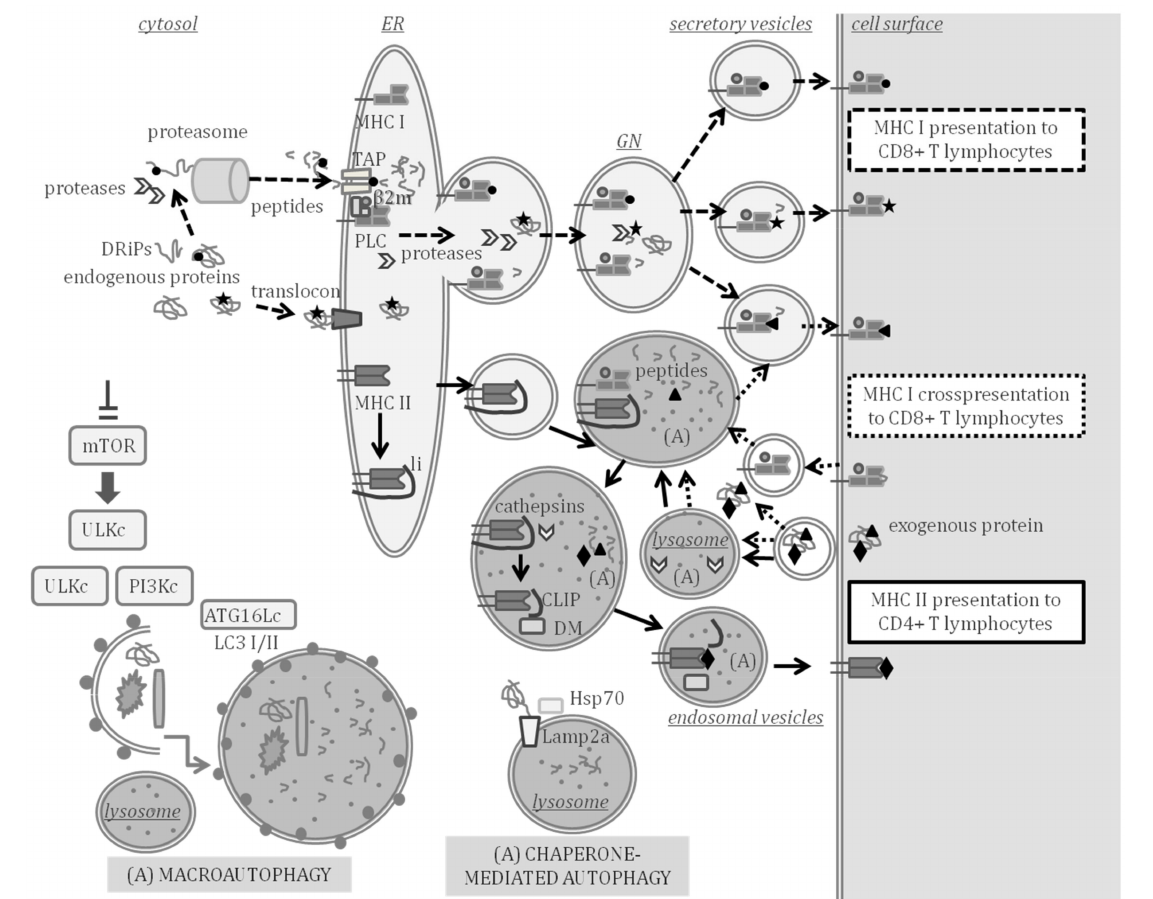
Figure 1. Major histocompatibility complex (MHC) class I and II antigen processing and presentation (APP) and autophagy. MHC class I presents endogenous peptides produced in the cytosol (peptide represented by a circle) or in secretory compartments (star) to CD8 + T lymphocytes through the pathways indicated with the dashed arrows. Endogenously synthesized proteins and defective ribosomal products (DRiPs) are processed to peptides in the cytosol by the proteasome and cytosolic proteases. Peptides are then transported by transporter associated to antigen processing (TAP) to the ER where the peptide loading complex (PLC) is formed by a peptide, TAP, MHC class I, β 2- microglobulin ( β 2m) and other assistant proteins. Endogenous proteins can enter the lumen of the ER through the translocon and be processed by proteases of the ER or the Golgi network (GN), thus, producing peptides that can also be loaded on MHC class I beyond the ER. Loaded MHC class I molecules are transported to the cell surface in secretory vesicles. MHC class I can also cross present peptides and prime CD8+ T lymphocytes through the pathway indicated with the dotted arrows. Cross-presented peptides (triangle) are produced by processing exogenous antigens in the cytosol or in secretory or endocytic compartments in which autophagy (A) may take place. MHC class II presents peptides (diamond) processed from exogenous proteins to CD4 + T lymphocytes through the pathway indicated with the continuous lined arrows. In the ER, MHC class II molecules are assembled and bind to the invariant chain li. The MHC class II is exported to endosomal compartments, in which autophagy can take place and where class II-associated invariant chain peptide (CLIP) remains bound to MHC class II after cleavage of li by lysosomal cathepsins. HLA-DM assists in the exchange of CLIP by a peptide that is exported to the cell surface through exocytic vesicles. Chaperone-mediated autophagy allows the targeting of cytosolic proteins to be degraded in lysosomes and is assisted by Lamp2a, Hsp70 and other chaperones. Macroautophagy is the engulfment of diverse cytosolic material to be degraded, induced by inhibition of the mammalian target of rapamycin (mTOR). Several multiprotein complexes (ULK, PI3K and ATG16L1) are involved in the formation of